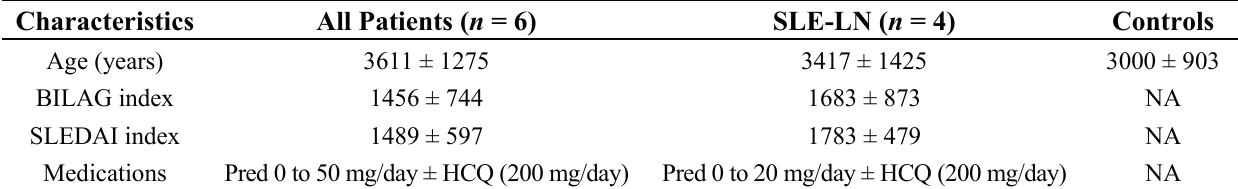
Table 1. Clinical characteristics of SLE patients and healthy